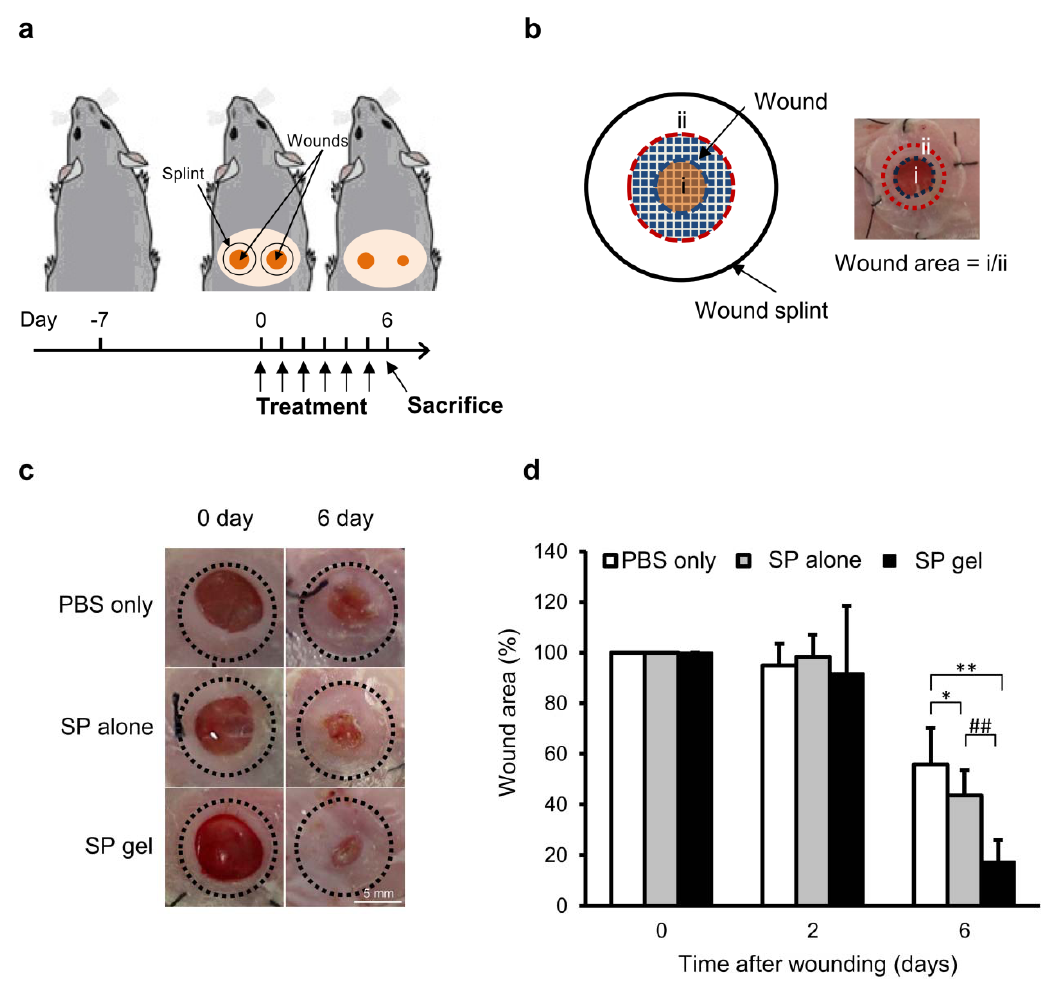
Figure 5. In vivo assessment of the efficacy of SP gel for healing mouse excisional wounds. ( a ) Schematic of the time course of the mouse excisional wound splinting model. ( b ) Relative wound area was calculated as actual wound area (i) divided by splinted hole area (ii). ( c ) Wound closure upon treatment with SP alone, SP gel, or PBS alone was monitored every 24 h. Representative images of wounds on day 0 and 6 are shown. ( d ) Changes in wound area at indicated time points relative to the original area. Values represent mean ± SD ( n = 13 for PBS alone, n = 8 for SP alone, and n = 5 for SP gel). * p < 0.05, ** p < 0.01 vs. PBS ‐ only negative control; ## p < 0.01 vs. SP alone (Student’s t test).